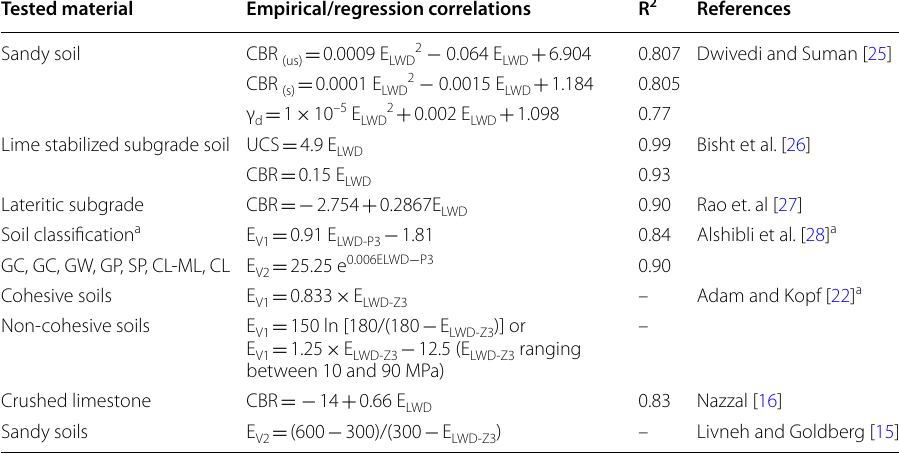
Table 4 Correlations between LWD and other devices for various compacted